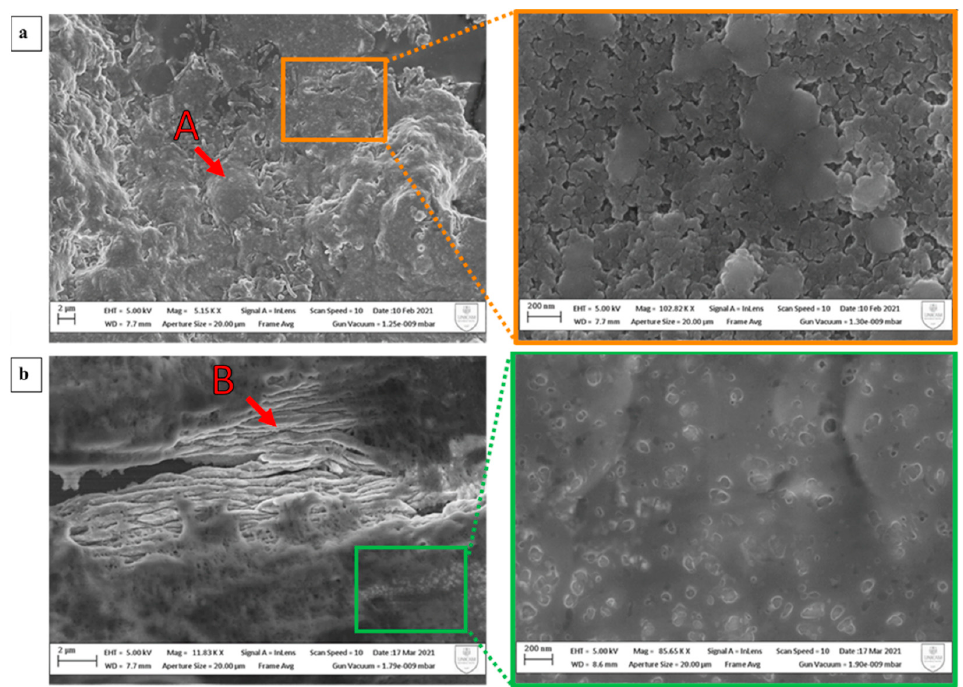
Figure 7. SEM images at different magnifications of keratin films obtained by drop-casting deposition. ( a ) The images of keratin extracted from wool. Point A indicates globular structure. ( b ) The images of keratin extracted from feathers. Point B indicates elongated structures, with a section of approximately 0.5 µm and a length in the order of 10 µm, hence with aspect ratio = ~ 20.